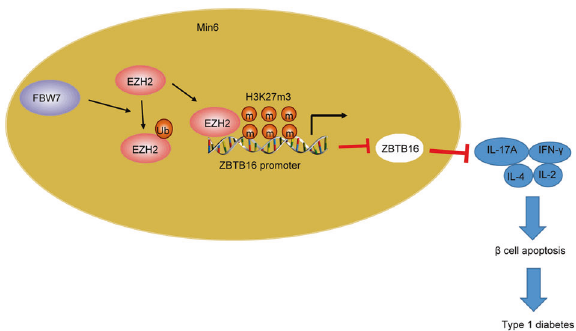
Fig. 6 The mechanism graph of the regulatory network and function of FBW7. E3 ubiquitin ligase FBW7 prevents T1D by upregulating ZBTB16 expression via histone methyltransferase